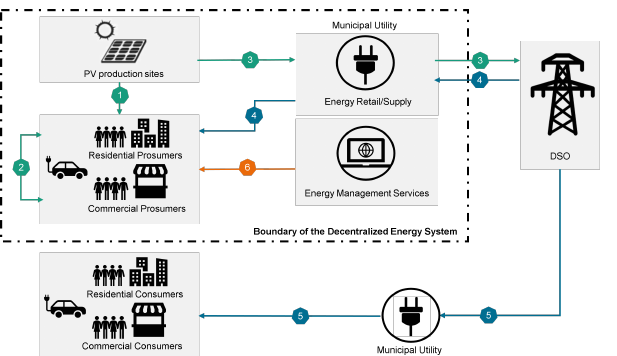
Figure 1. Activities and energy flows within the decentralised energy system. PV flows (in green): 1. generation and self-consumption; 2. energy sharing within the community; 3. excess feed-in to grid. Utility supply (in blue): 4. to the REC members; 5. to non-members. 6. Flexibility through demand response by shifting the timing of EV charging (in